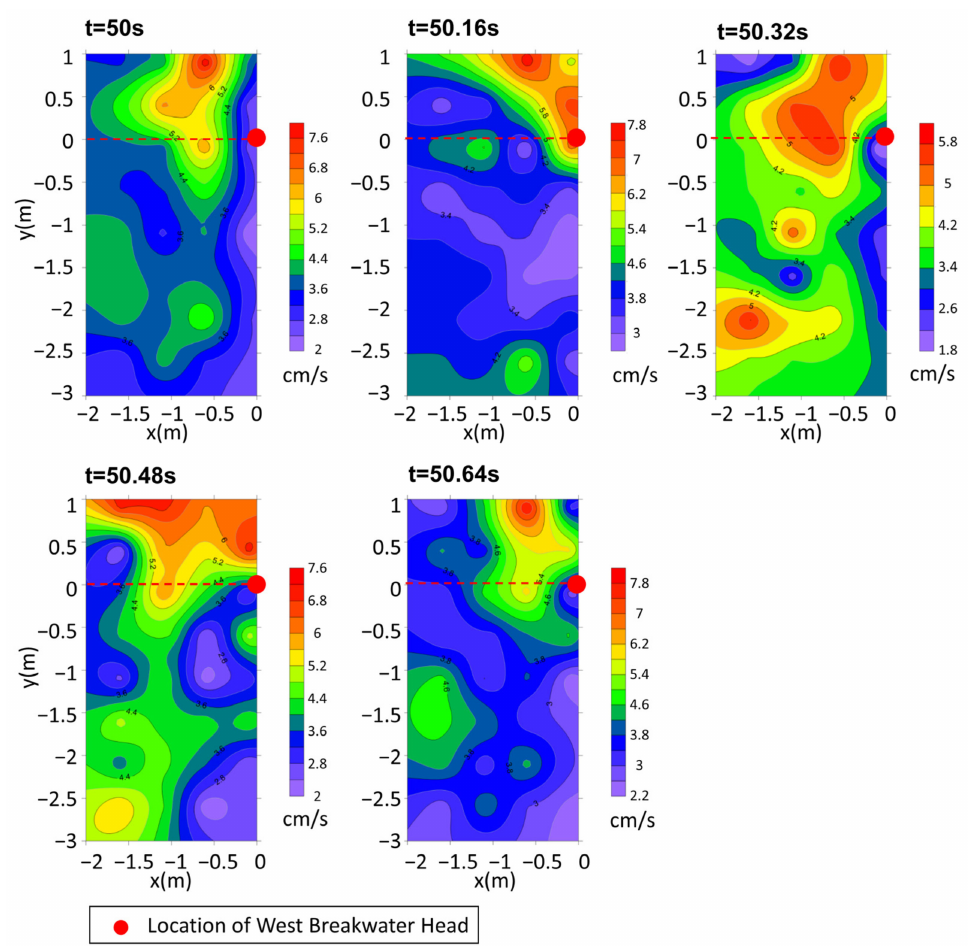
Figure 22. U at west side of the West Breakwater under the action of monsoon waves (z = − 15 m). (2) Topographic changes The topographic changes near the breakwater head are measured with 200 wave periods (about 126 s) each time the Northward monsoon wave acts. The scale of